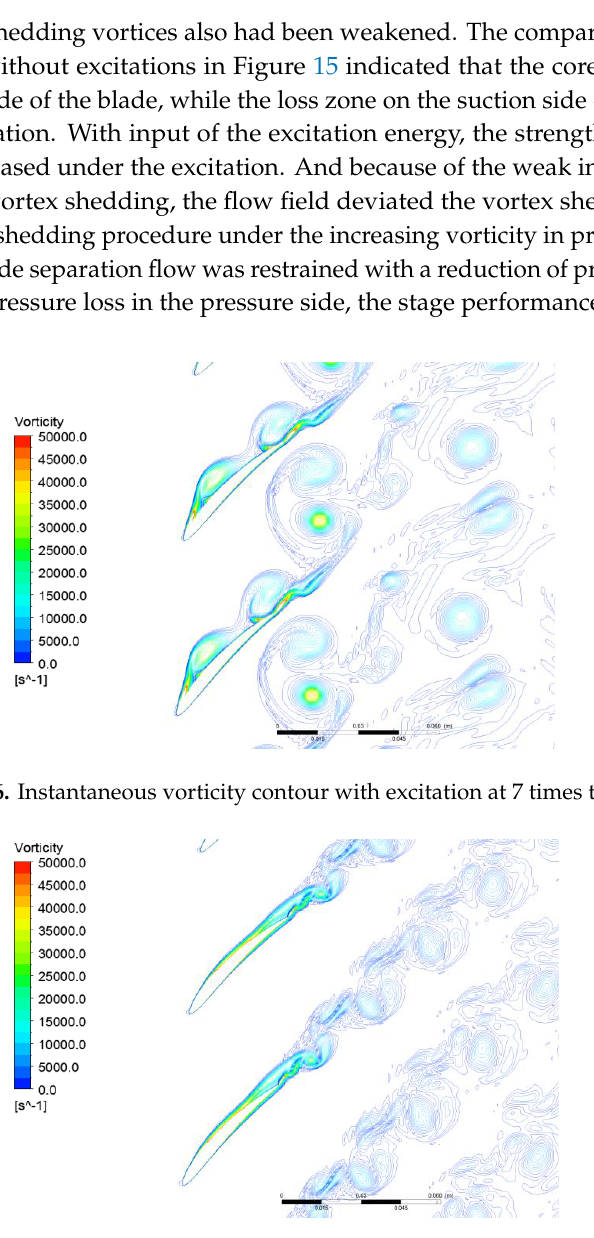
Figure 17. Instantaneous vorticity contour with excitation at 28 times the